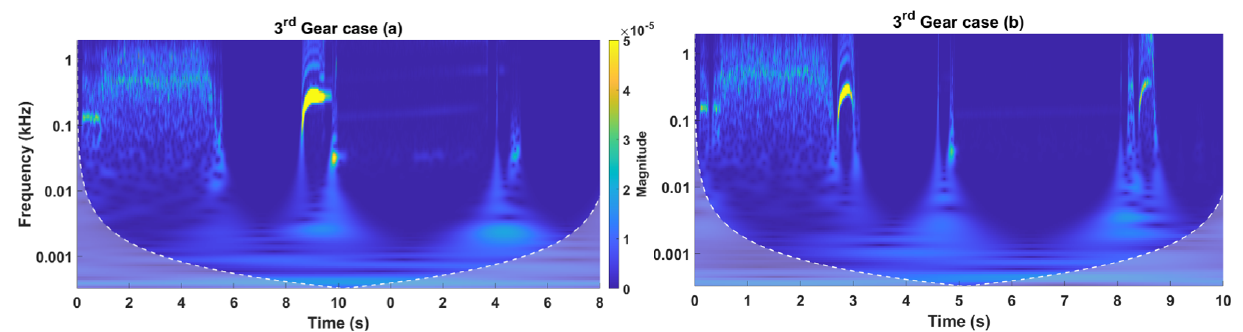
Figure 13. Time-Frequency Wavelet Transform: 2nd gear.